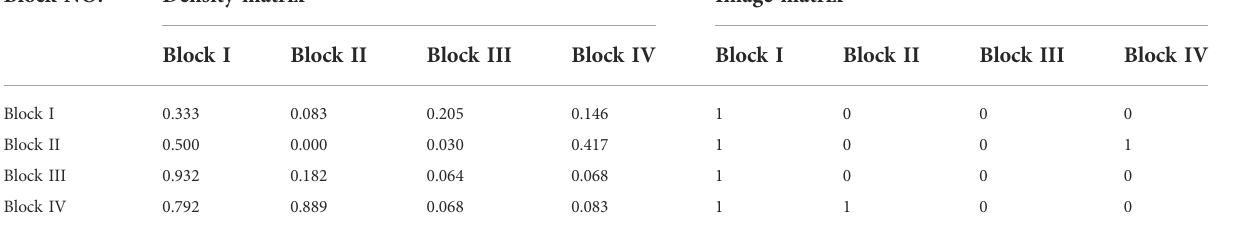
TABLE 5 The block density matrix and the image matrix. Block